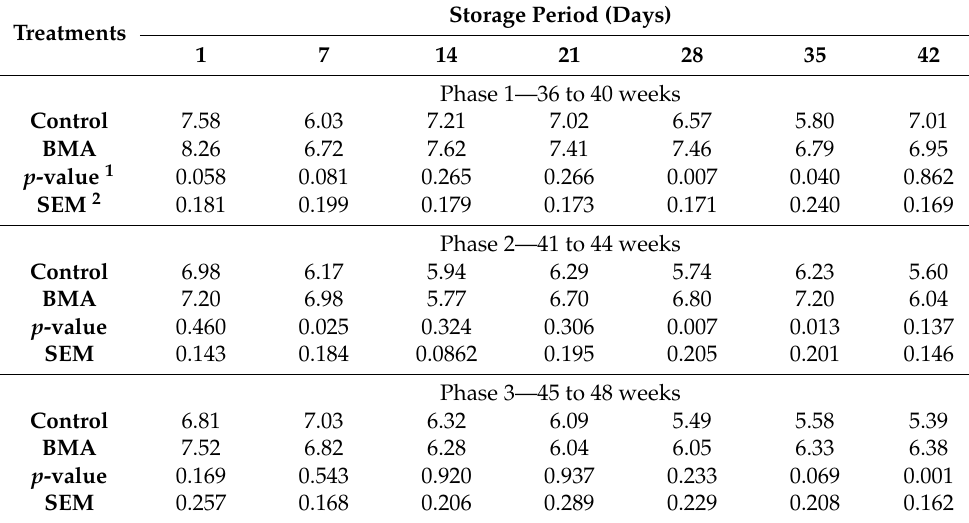
Table 6. Yolk redness (a* color) of eggs from laying hens fed with β -mannanase depending on storage time. Treatments